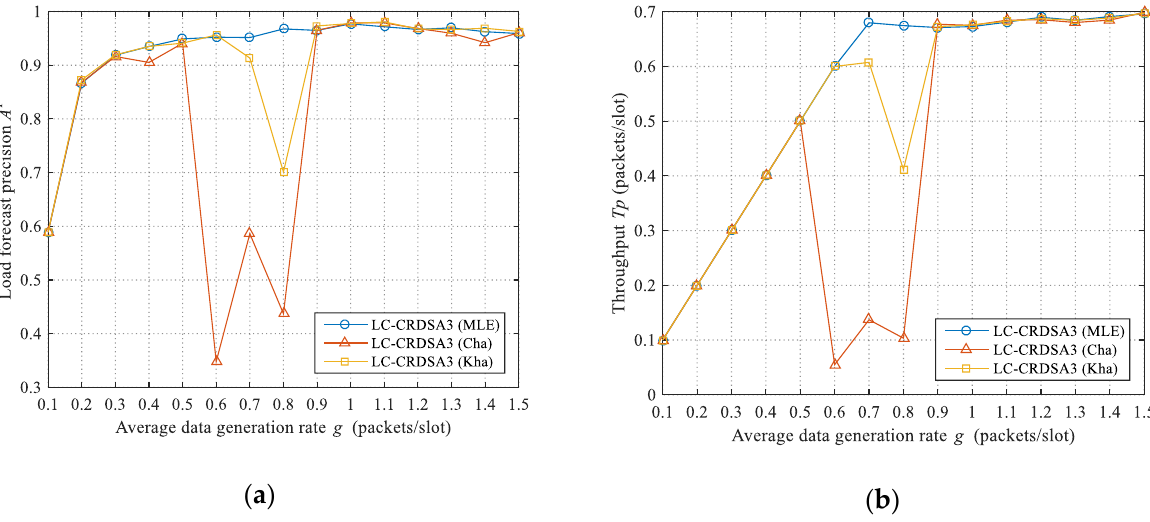
Figure 4. Load forecast precisions and throughput under the three load estimation algorithms: ( a ) Load forecast precisions under the three algorithms; ( b ) Throughput under the three algorithms.